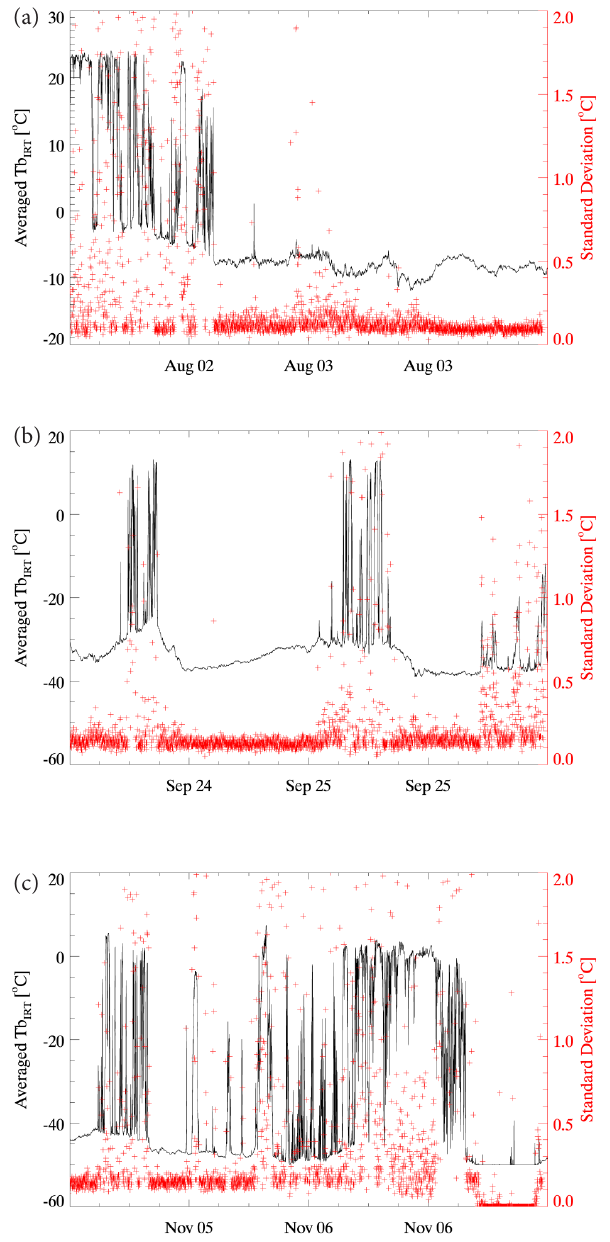
Figure 8. Time series of one-minute averaged Tb IRT (black solid line, reference scale on the left) and its standard deviation (red cross, reference scale on the right) for 48h during the summer (a) , the fall (b) and the winter (c) periods. Time duration with relatively cold and homogeneous Tb IRT is well represented by the relatively small and stable value of the standard deviation.